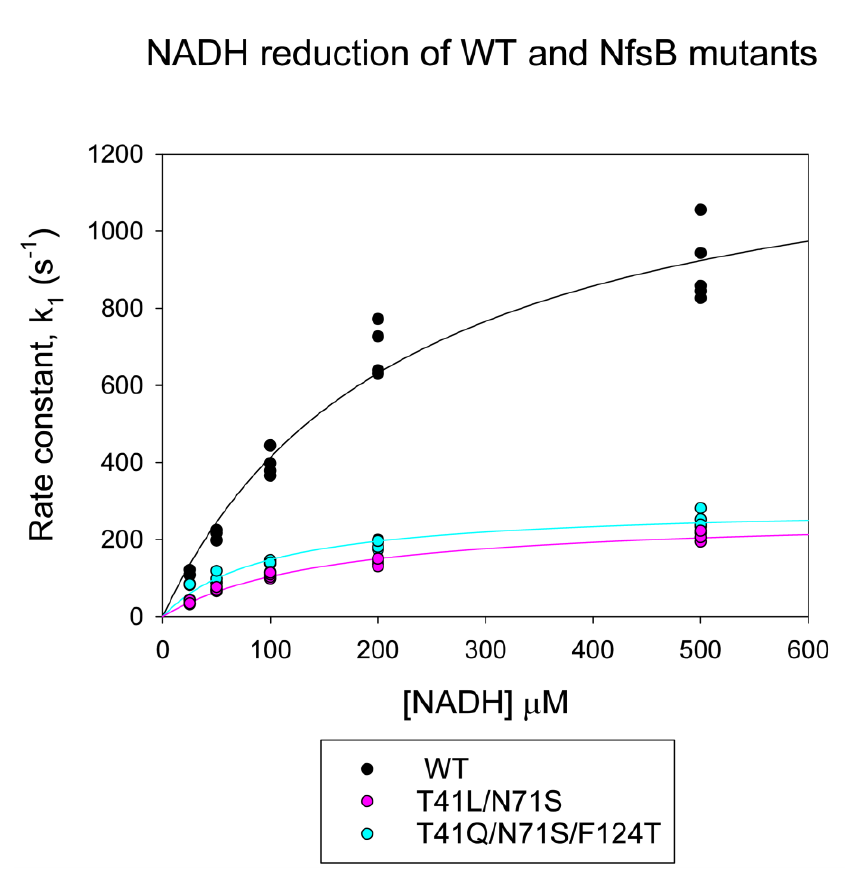
Figure 3. Plots of pseudo-first-order rate constants k 1 vs. NADH concentration for the reduction of NfsB and mutants by NADH, monitored by stopped-flow. Rate constants were calculated by fitting the absorbance at 340 nm with time after addition of NfsB to an exponential equation. The reactions were done in a 10 mM Tris HCl pH 7 buffer at 25 °C with 5 µM NfsB or mutants. Circles show the data points, while lines show the fits to a hyperbola, with the parameters in Supplementary Table S3. Black circles and lines represent wild-type NfsB, magenta circles and lines represent T41L/N71S NfsB, and cyan circles and lines represent T41Q/N71S/F124T NfsB.